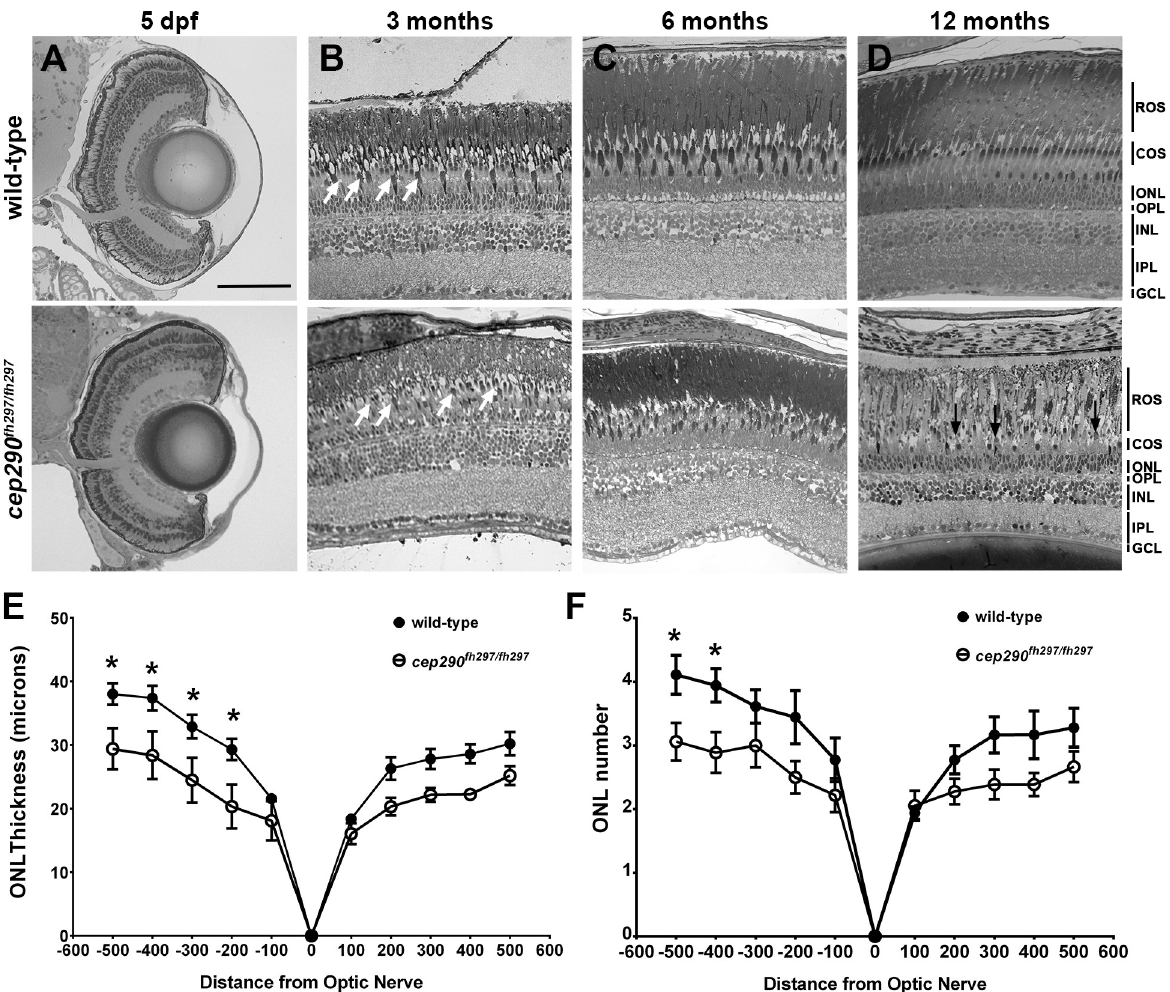
Fig 2. Progressive cone loss in adult cep290 fh297/fh297 mutants. Methylene blue stained transverse histological sections of retinas from wild-type (top) and cep290 fh297/fh297 mutants (bottom) at 5 dpf (A); 3 months of age (B), 6 months of age (C), and 12 months of age (D). At 3 months, the cep290 fh297/fh297 mutants (bottom) had noticeably fewer cones (white arrows) and thinning of the cone outer segment (COS) layer. Few cones were observed at 12 months of age in cep290 fh297/fh297 mutants (black arrows). (E) Quantification of ONL thickness and (F) rows of nuclei in the ONL at different distances from the optic nerve in both the dorsal (negative numbers; left) and ventral (positive numbers; right) retina of cep290 fh297/fh297 mutants and wild-type sibling controls at 8 months of age. Data are shown as means ± SEM (n = 6, � P � 0.05). ROS, rod outer segments; COS, cone outer segments; ONL, outer nuclear layer; OPL, outer plexiform layer; INL, inner nuclear layer; IPL, inner plexiform layer; GCL, ganglion cell layer. Scale bar: 100 μ m.